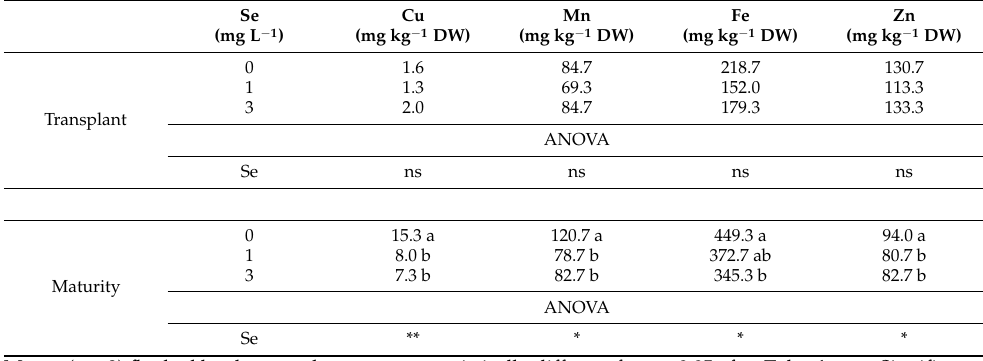
Means ( n = 3) flanked by the same letter are not statistically different for p = 0.05 after Tukey’s test. Significance level: ** p ≤ 0.01; * p ≤ 0.05. Both treatments with Se reduced total chlorophyll content, and exposure to 3 mg L − 1 decreased the total carotenoid content of seedling leaves (Figure 8A,B). However, a higher antioxidant capacity was detected in seedlings treated with 2 and 3 mg Se L − 1 , and a higher flavonoid content when seedlings were exposed to 3 mg Se L − 1 (Figure